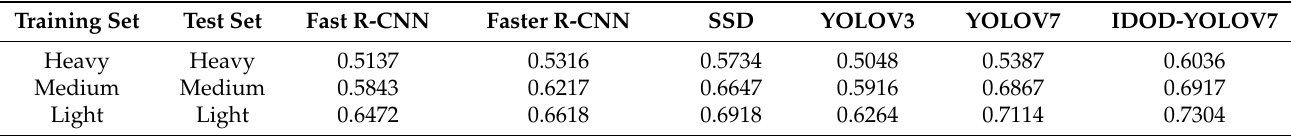
Table 3. The mAP comparison on the different object detection methods at three fog